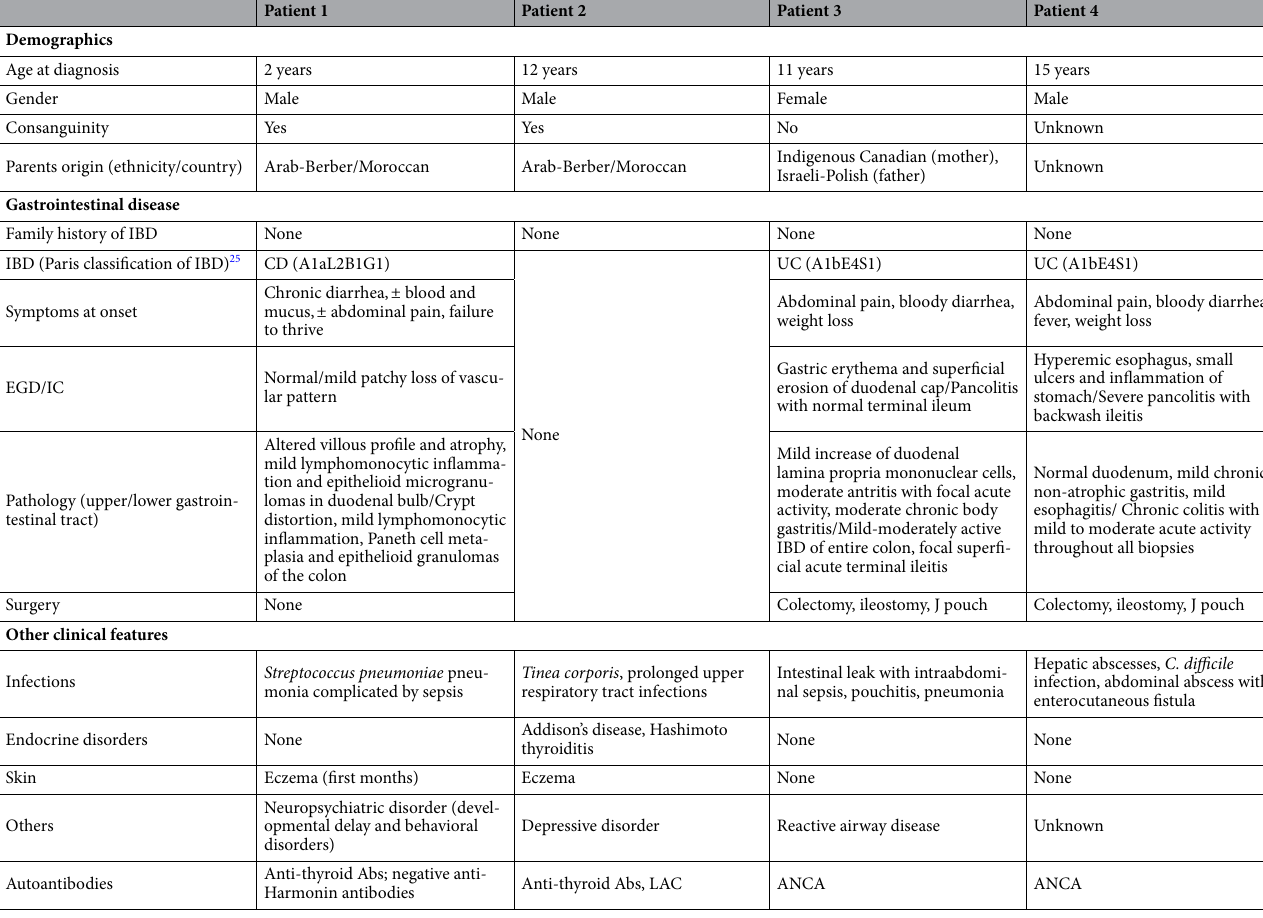
Table 1. Demographic and clinical features of CARMIL2-deficient patients. EGD esophagogastroduodenoscopy, IBD inflammatory bowel disease, IC ileocolonoscopy, LAC Lupus anticoagulant.